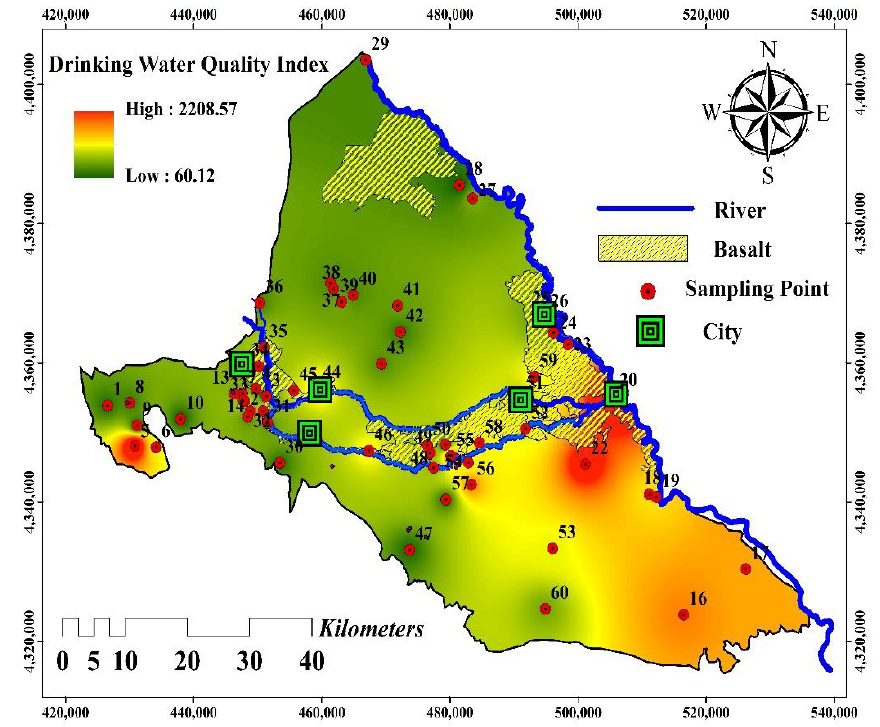
Figure 7. Drinking Water Quality Index map of the Maku – Bazargan – Poldasht area.